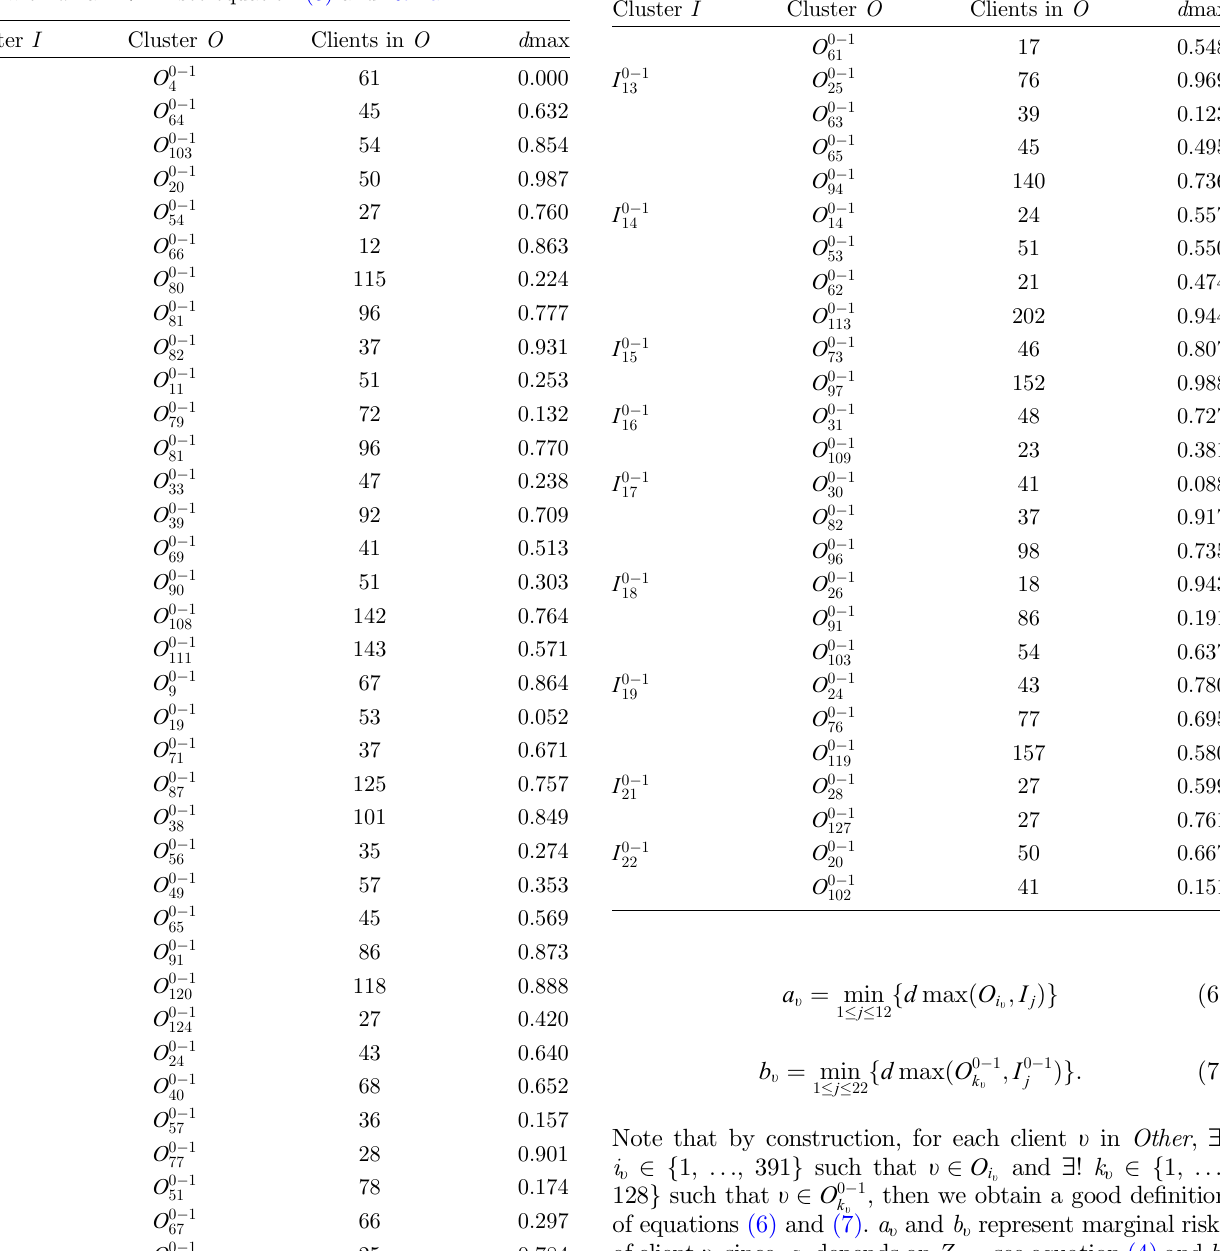
Table 13. For I 0 (cid:3) 1 , i 6¼ 20, i = 1, . .. , 22 are reported the clusters i O 0 (cid:3) 1 with d max < 1 – see equation (5) and Remark j